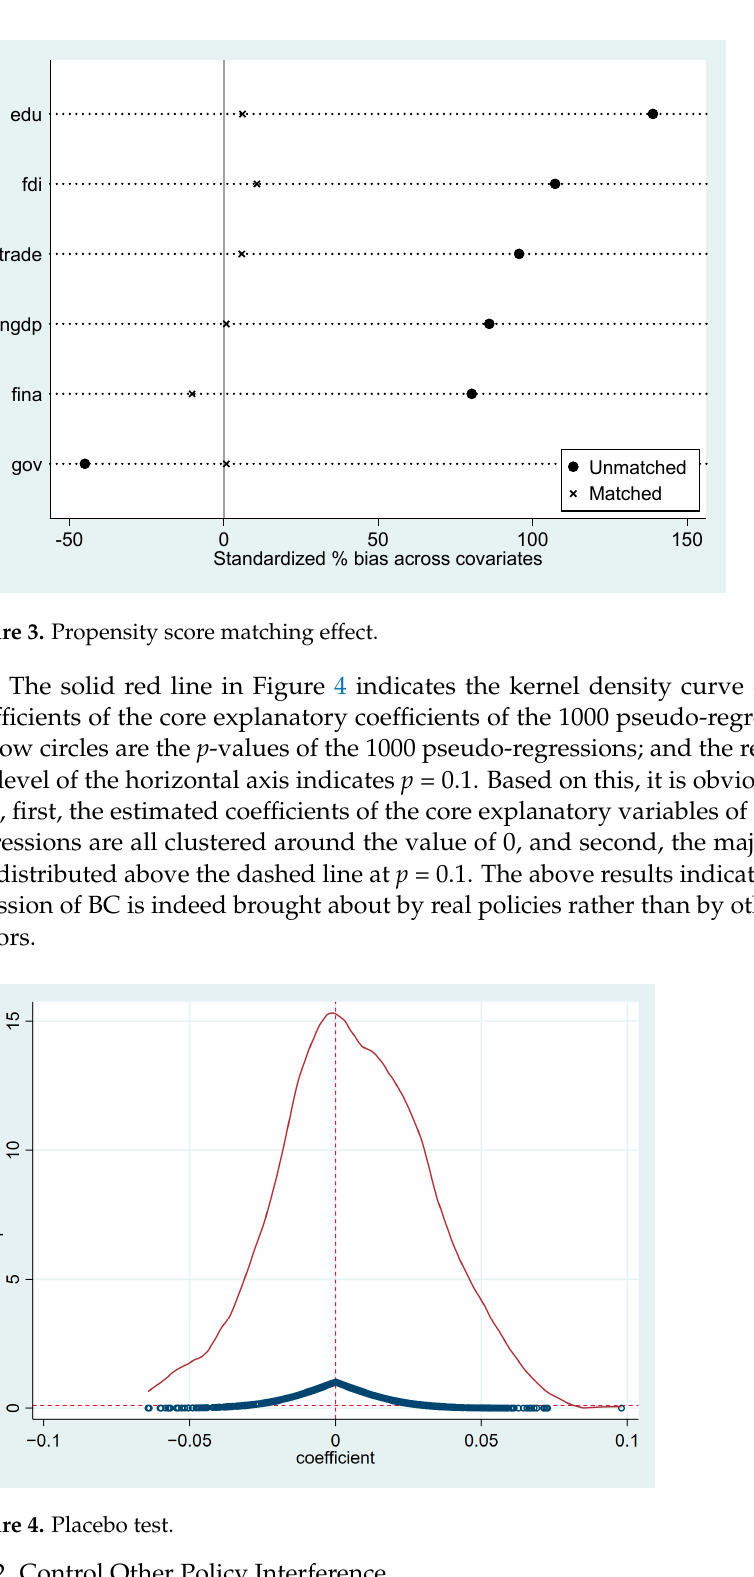
Figure 4. Placebo